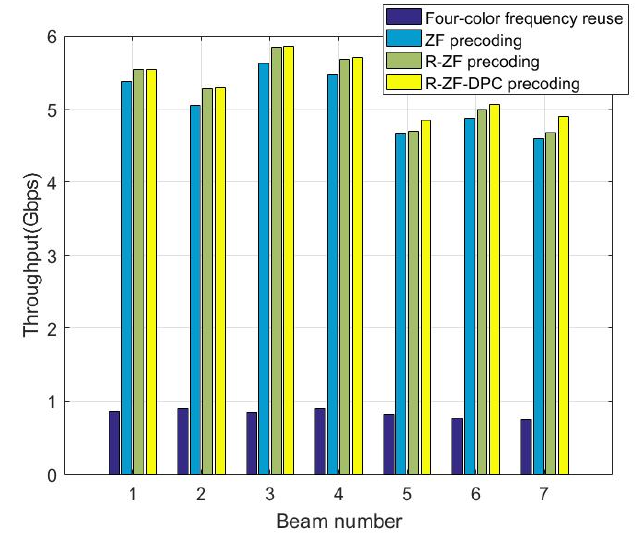
Figure 4. Performance diagram of each beam throughput of four precoding schemes.